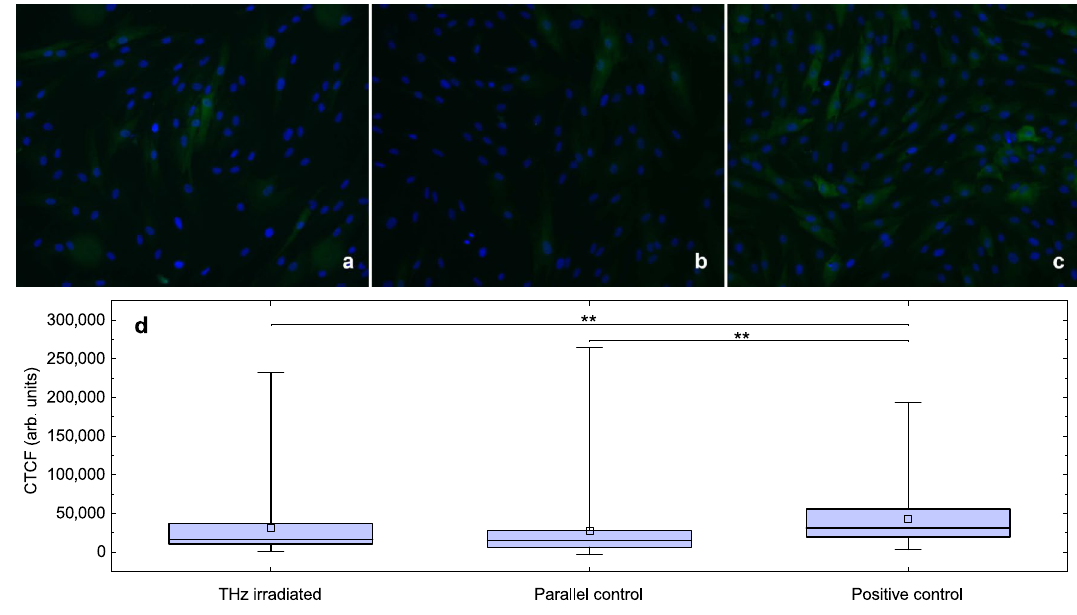
Figure 5. HSPs expression in human fibroblasts. ( a ) Experimental group after exposure to intense pulses of THz radiation for 180 min. ( b ) Control group (no irradiation or external heating). ( c ) Cells after incubation at 40 ◦ C in positive control group, ( d ) Mean fluorescence intensity of secondary goat anti-mouse IgG (H + L) antibodies. N > 50 cells/group. Asterisks indicate a statistically significant difference (** p < 0.05 by Mann- Whitney